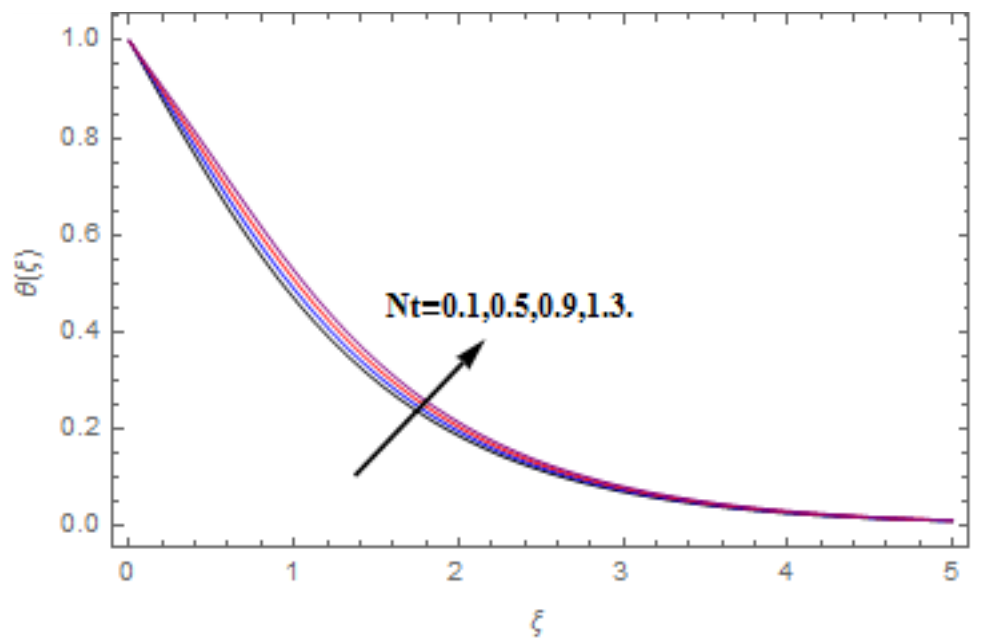
θ ( ξ ) against Nt , when M = ψ = 0.2, Nb = 0.5, Le = 1.0, Ec = 1.0, Pr = 1.2, Figure 15. Varation Figure 15. Varation in γ = 0.1, κ = 1.0. Molecules 2020 , 25 , x FOR PEER REVIEW